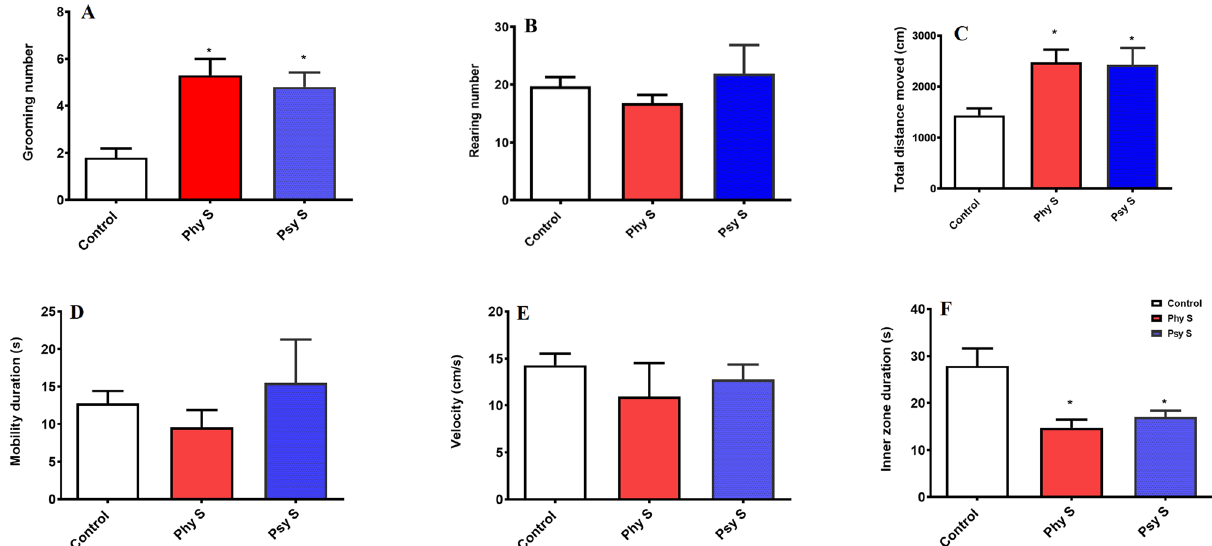
Figure 2. Comparison of the effect of PS on locomotor activity and anxiety-like behavior of the offspring in the open field test. ( A ) Frequency of grooming per session. ( B ) Frequency of rearing per session. ( C ) Total distance moved. ( D ) Duration of mobility. ( E ) Mean velocity. ( F ) Time spent in the center zone. Data are displayed as Mean ± SEM. Phy s: physical stress, Psy s: psychological stress, * ( p < 0.05), ** ( p < 0.01), *** ( p < 0.001) compared to the control group.